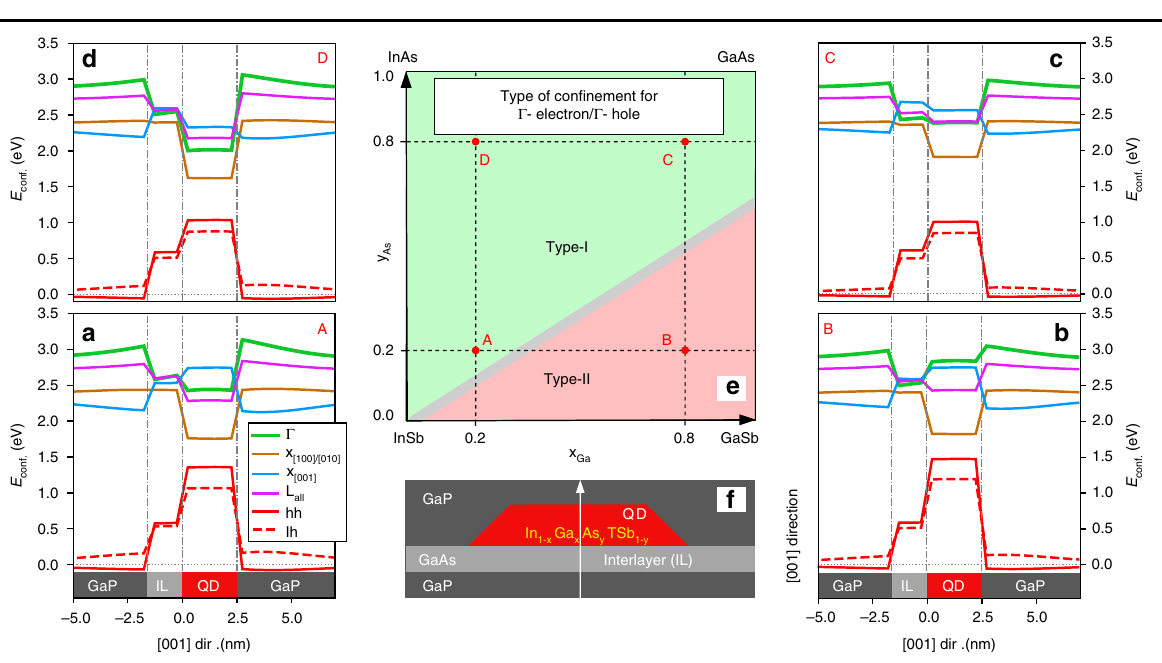
Fig. 9 a – e Local band-edges ( Γ , X, and L) along the QD vertical symmetry axis [001] depicted by the arrow in f . The letters A, B, C, and D represent the material content as shown in e . Type of con fi nement derived from a – e for Γ -electron/ Γ -hole bands